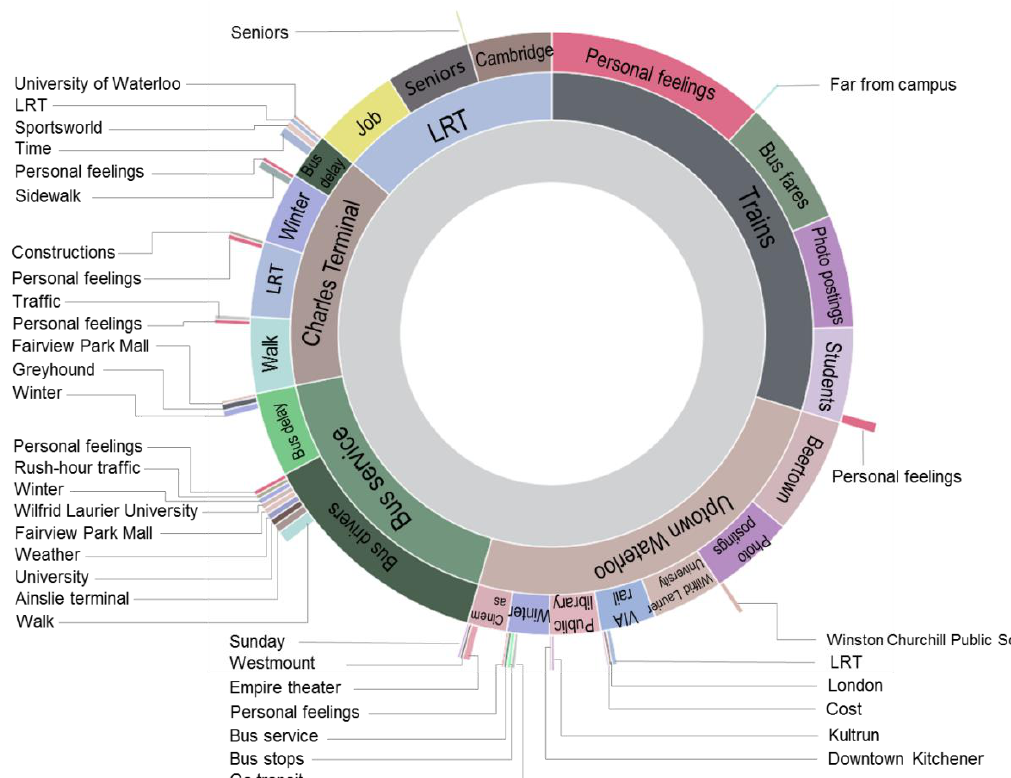
Figure 9. An overview of topic hierarchy generated from Twitter Tweets.